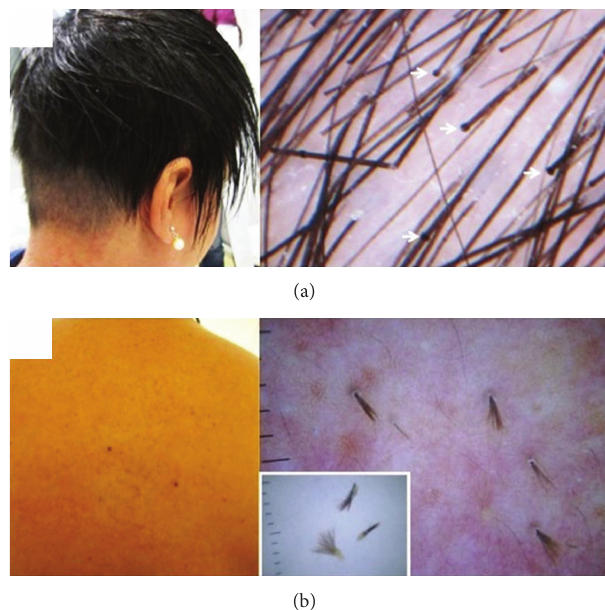
Figure 2: Rare hair shaft abnormalities. (a) Trichorhexis invagi- nata in a patient with Com`el-Netherton syndrome. Clinically hair appears sparse, brittle, and short; trichoscopy shows nodes along the hair shafts (white arrows). (b) Pili multigemini on the back. Dermoscopyhighlightingthemultiplehairshaftsemergingfromthe same follicular ostia. Dermlite II Pro (3 Gen, San Juan Capistrano, CA,